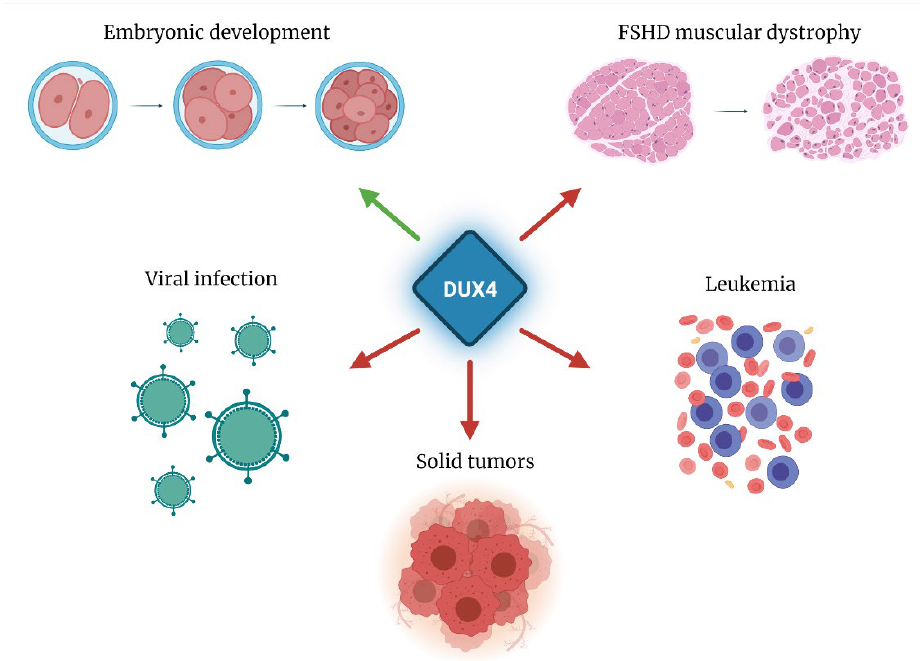
Figure 1. Physiological (green arrow) and pathological (red arrows) roles of DUX4. DUX4 is physiologically expressed during early embryogenesis and subsequently silenced in most somatic tissues. DUX4 can be re-expressed as direct consequence of Herpesviridae infection. DUX4 pathological gain of expression is associated with FSHD muscular dystrophy. Several forms of neoplasms display aberrant DUX4 expression or activity.